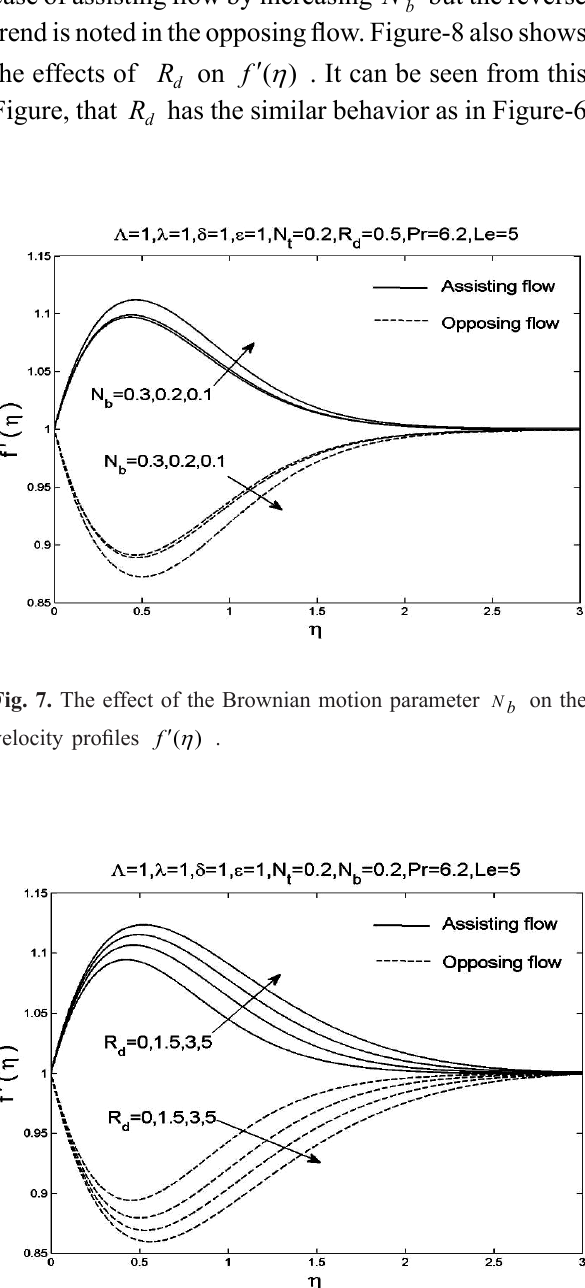
Fig. 8. The effect of the radiation parameter d R on the velocity profiles ( ) f η′ .